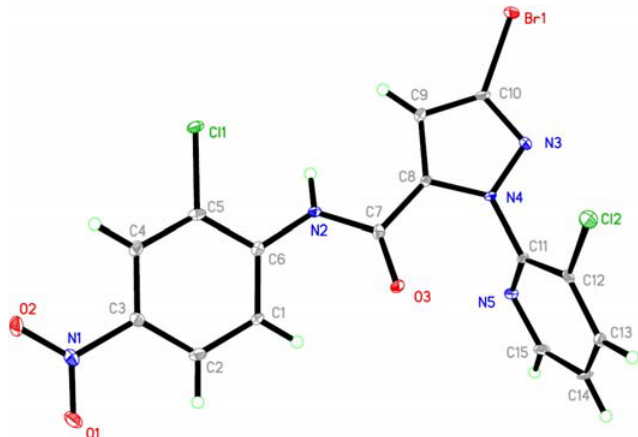
Figure 2. The molecular structure of 7l .